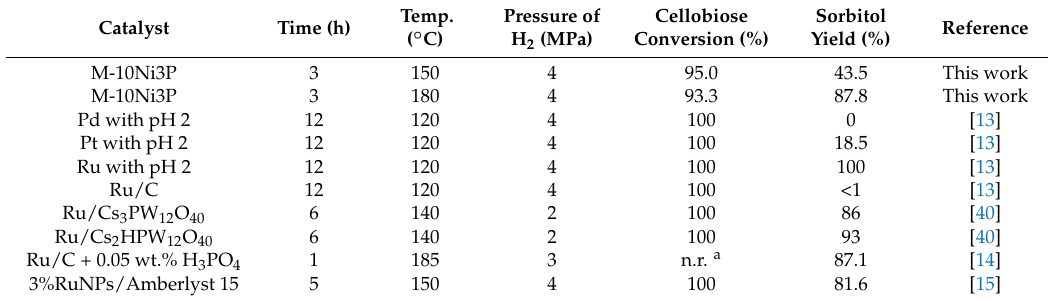
Table 3. Comparison of catalytic performance of various catalysts for cellobiose conversion to sorbitol.